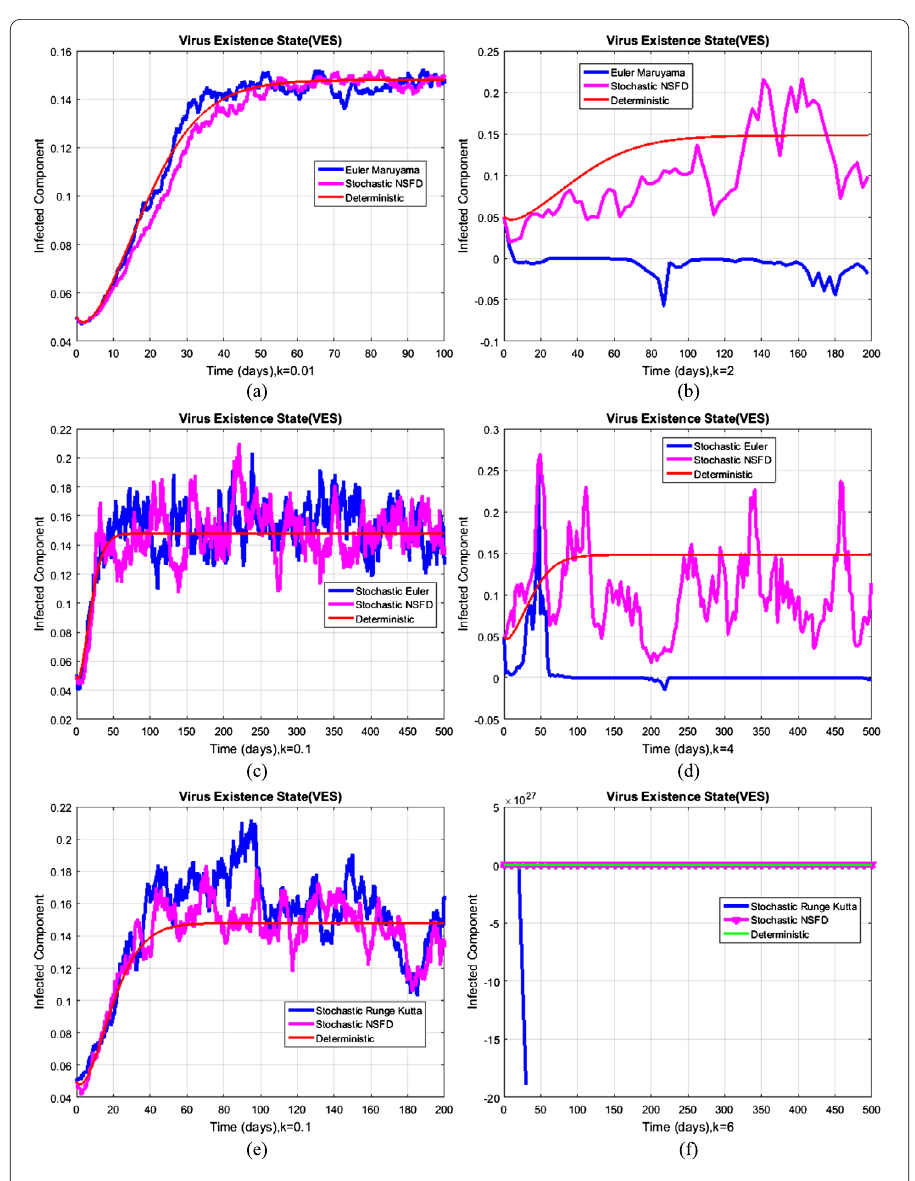
Figure 3 Comparison graph of computational methods at the existence of coronavirus state